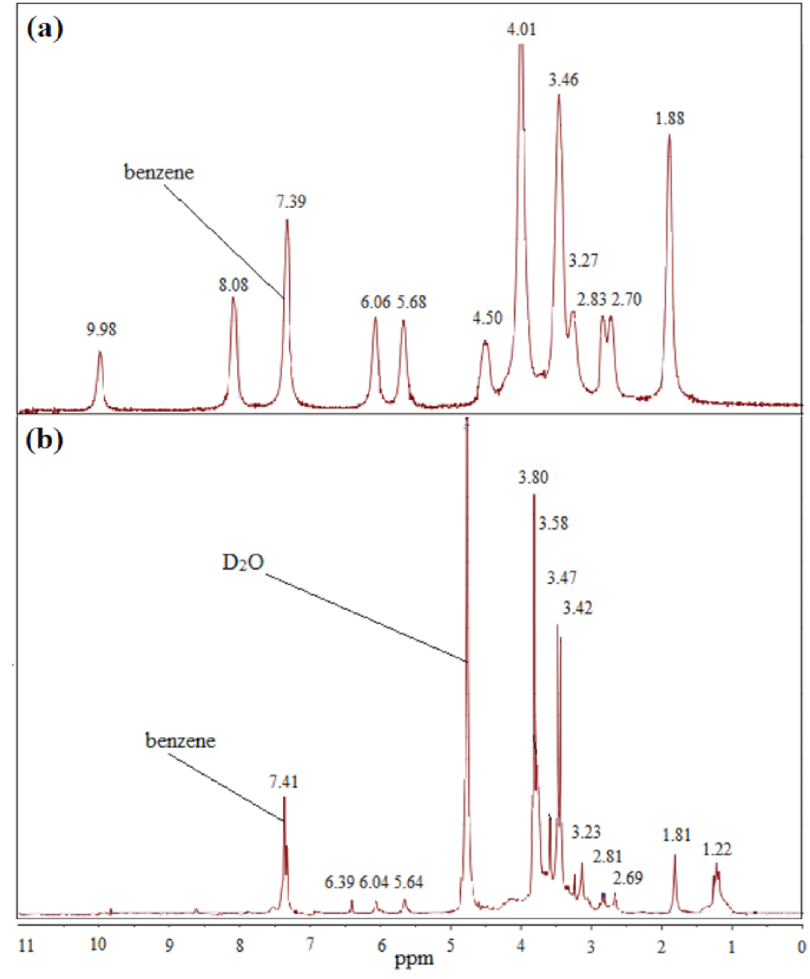
Figure 1. NMR 1 H spectra of a mixture of GMA and POOS at temperatures: ( a )—298 K; ( b )—323 K after holding for 8 h (with the addition of D 2 O when registering the NMR 1 H